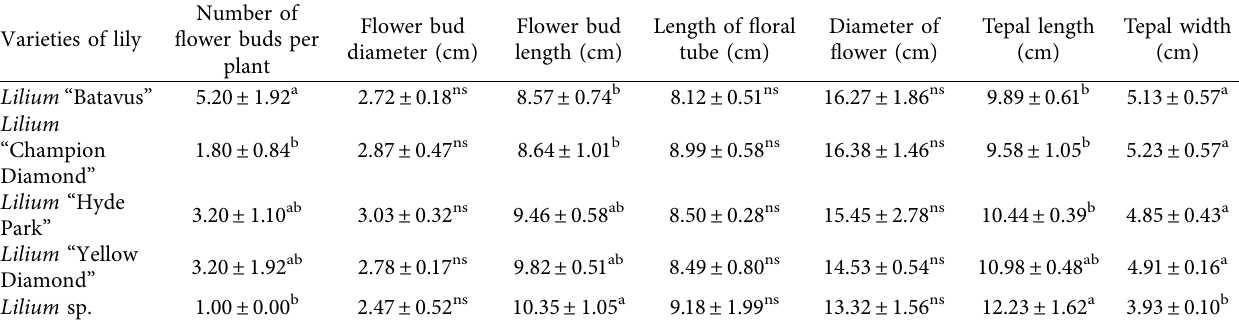
Table 2: Comparison of the marketing (flowering) characteristics of five varieties of lilies grown from in vitro regeneration of microbulbs. Varieties of lily